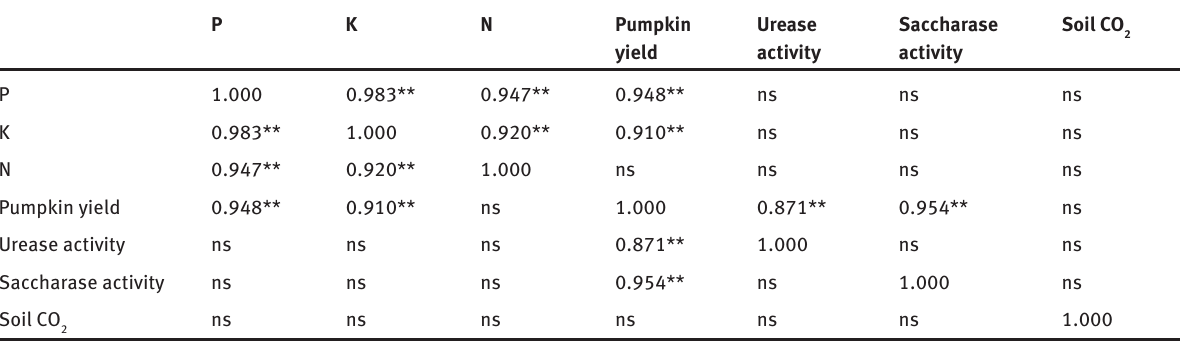
Table 4: Correlation between pumpkin yield and soil